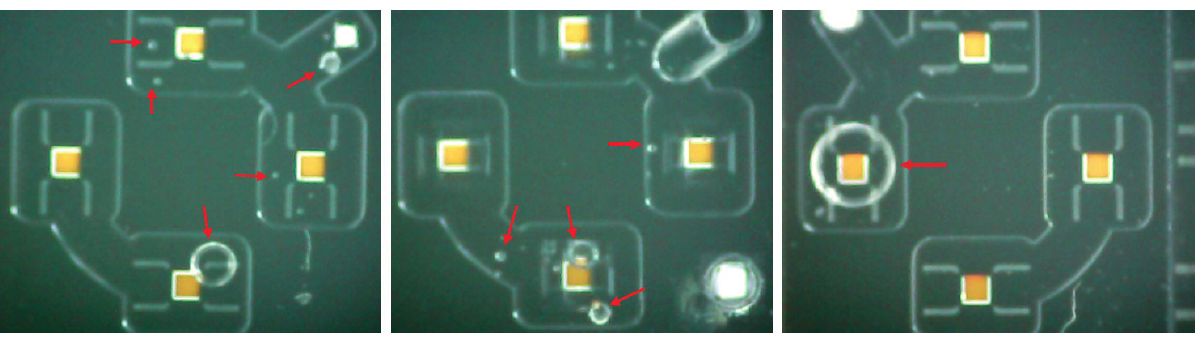
Figure 5. Micro-bubbles that can appear with incorrect filling methods, in the MEMS-microfluidic sensors. The micro-bubbles are indicated with red arrows